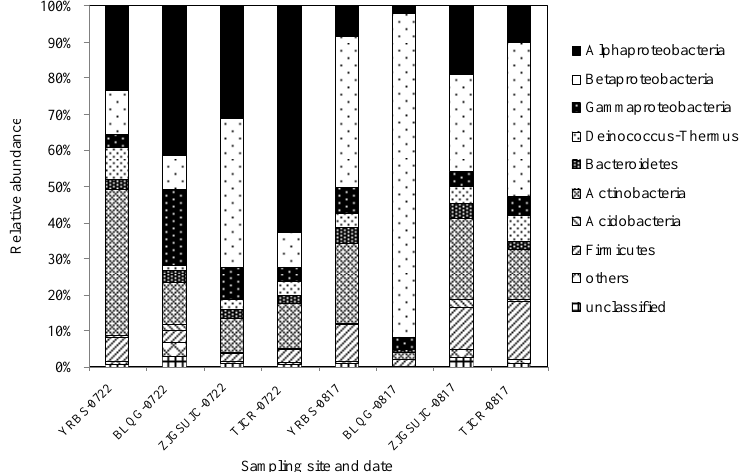
Figure 4. Types and abundance of airborne bacteria at Phylum taxonomic levels before and after heat events.